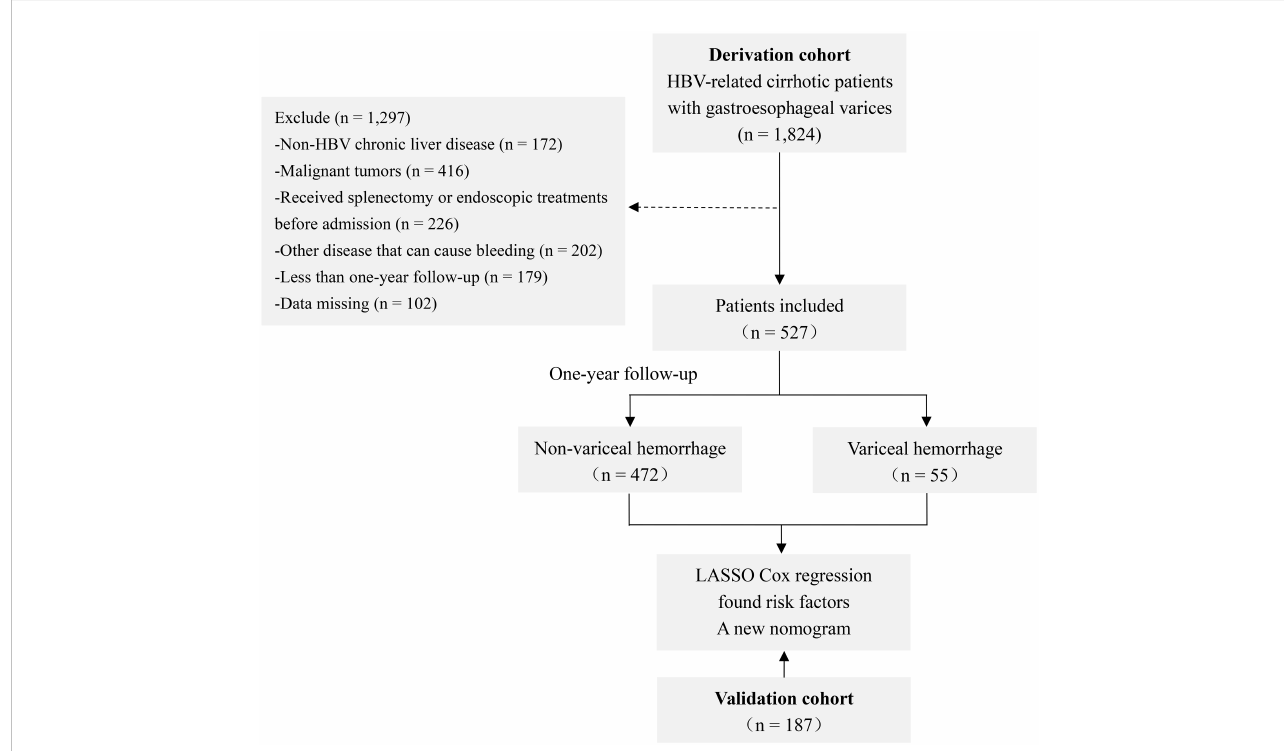
FIGURE 1 Study fl ow chart. Abbreviations: HBV, hepatitis B virus; LASSO, least absolute shrinkage and selection